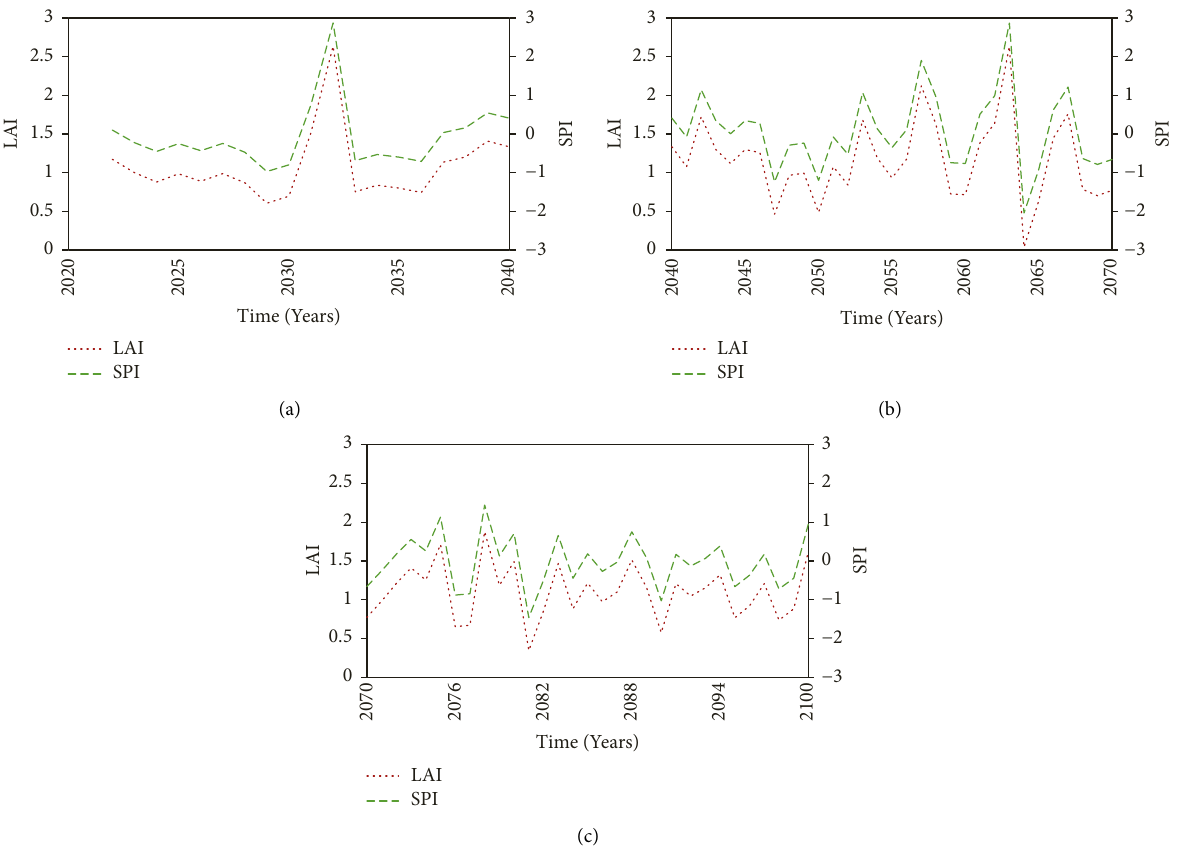
Figure 7: Projected SPI and LAI under RCP8.5 climate scenario. (a) For 2022–2040. (b) For 2041–2070. (c) For